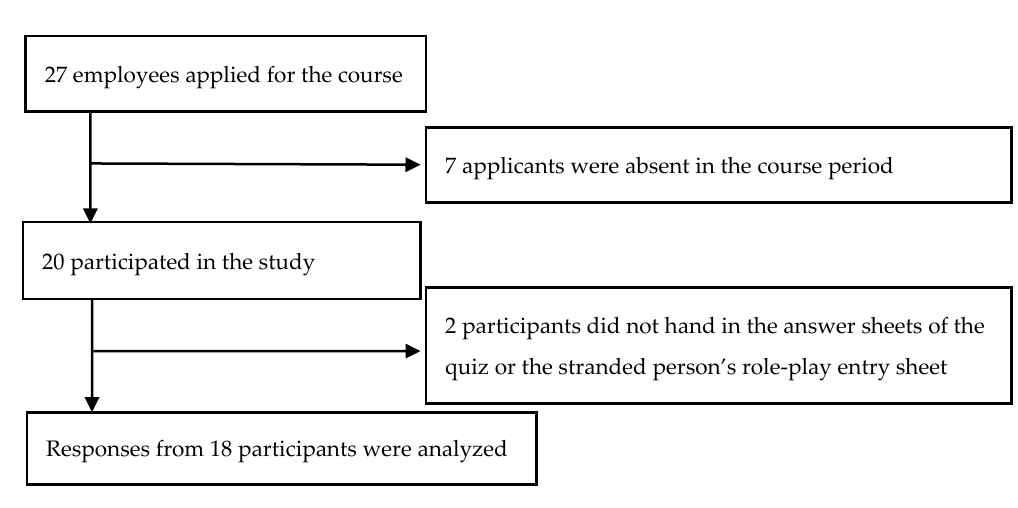
Figure 1. Tree diagram of the change of the sample.